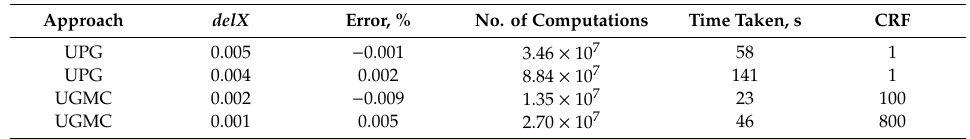
Table 3. Computation of view factor F 1-4 using UPG and UGMC routines. Example with perpendicular, split surfaces *, uniform